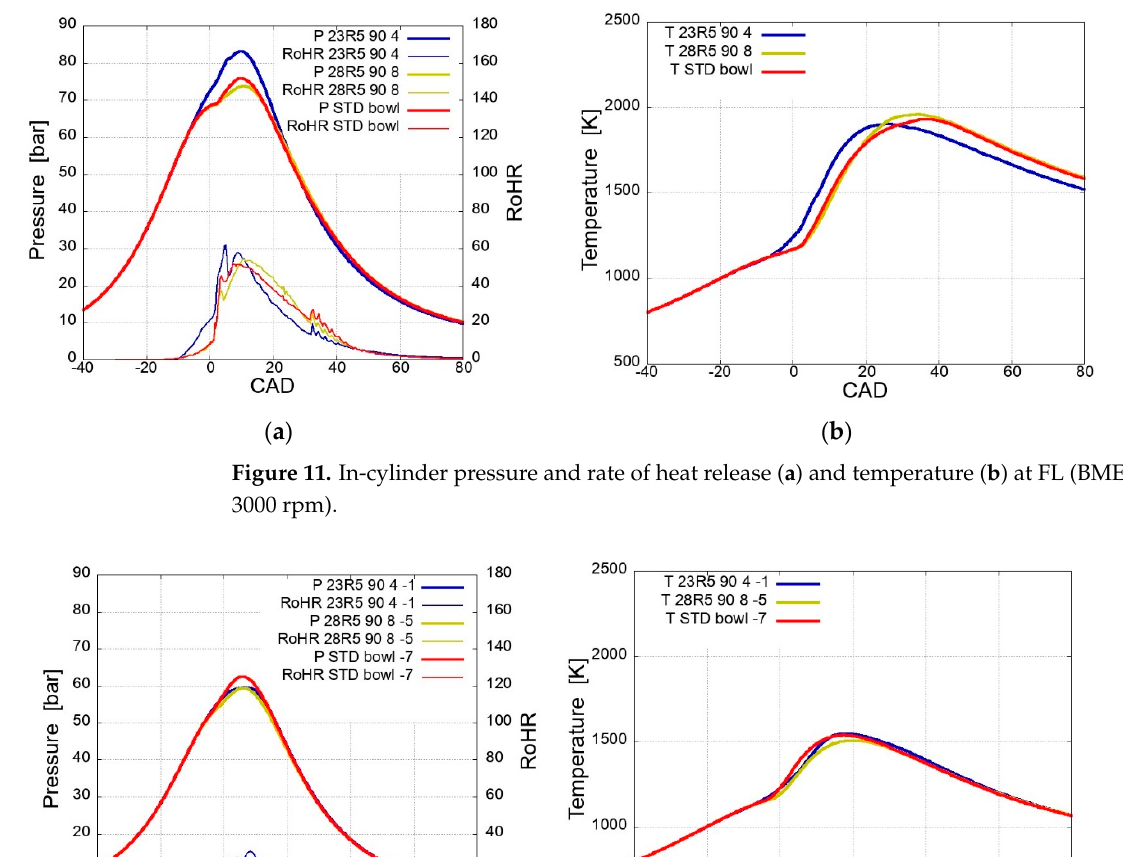
( b ) Figure 10. Comparison between the bowls at full load ( a ) and partial load ( b ): IMEP and NO x emis- sions . For a more detailed insight into the combustion process, Figures 11 and 12 present the traces of the in-cylinder pressure, temperature and rate of heat release (RoHR) at both full and partial loads. At FL, the behavior of 28R5 was very similar to that of the diesel